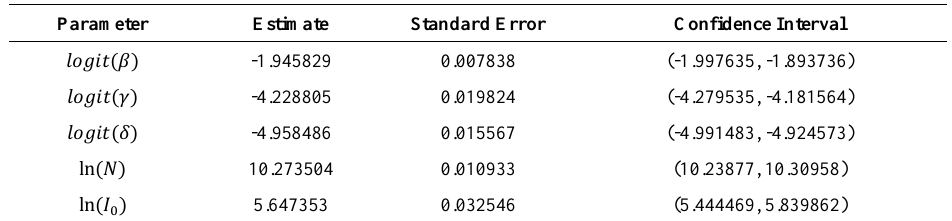
Table A18. Piedmont. Estimates, asymptotic standard errors, and 95% profile likelihood mCIs for the parameters of the SIRD model (12).